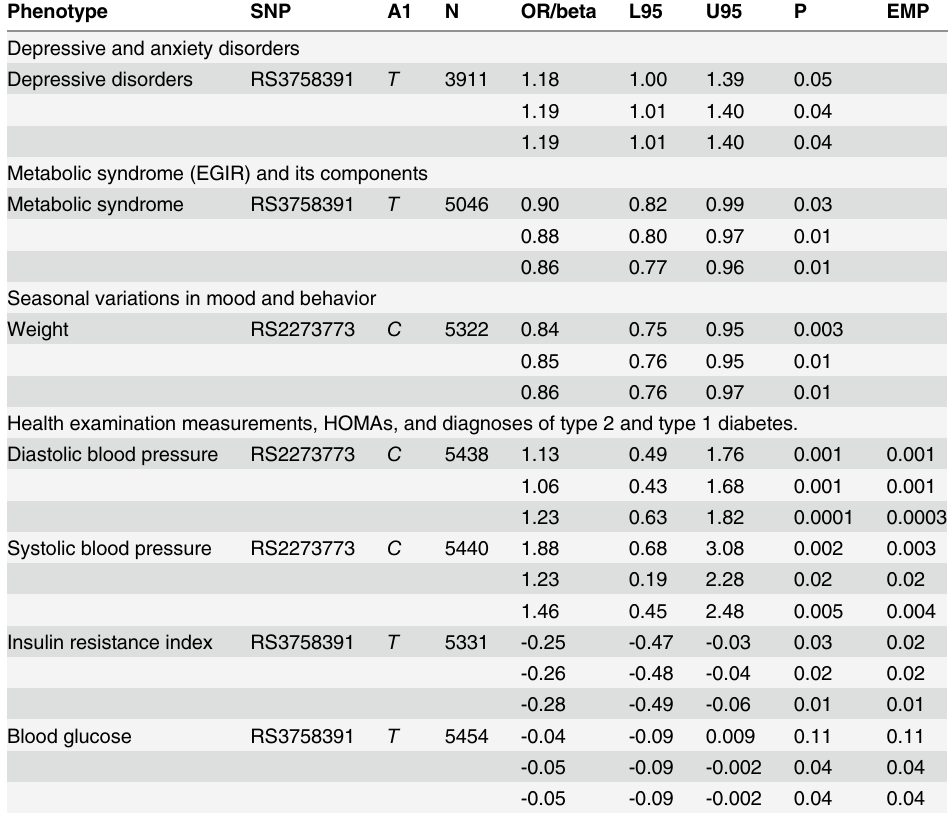
Table 3. Results (P/EMP < 0.05) of the SIRT1 SNP associations (unadjusted on the first line / age and sex adjusted on the second line / age, sex and BMI adjusted on the third line). A1; Tested allele (minor allele). N; Number of genotypes for the phenotype. L95, U95; Lower and upper bounds of 95% confidence interval for odds ratio. P/EMP: p-value / empirical